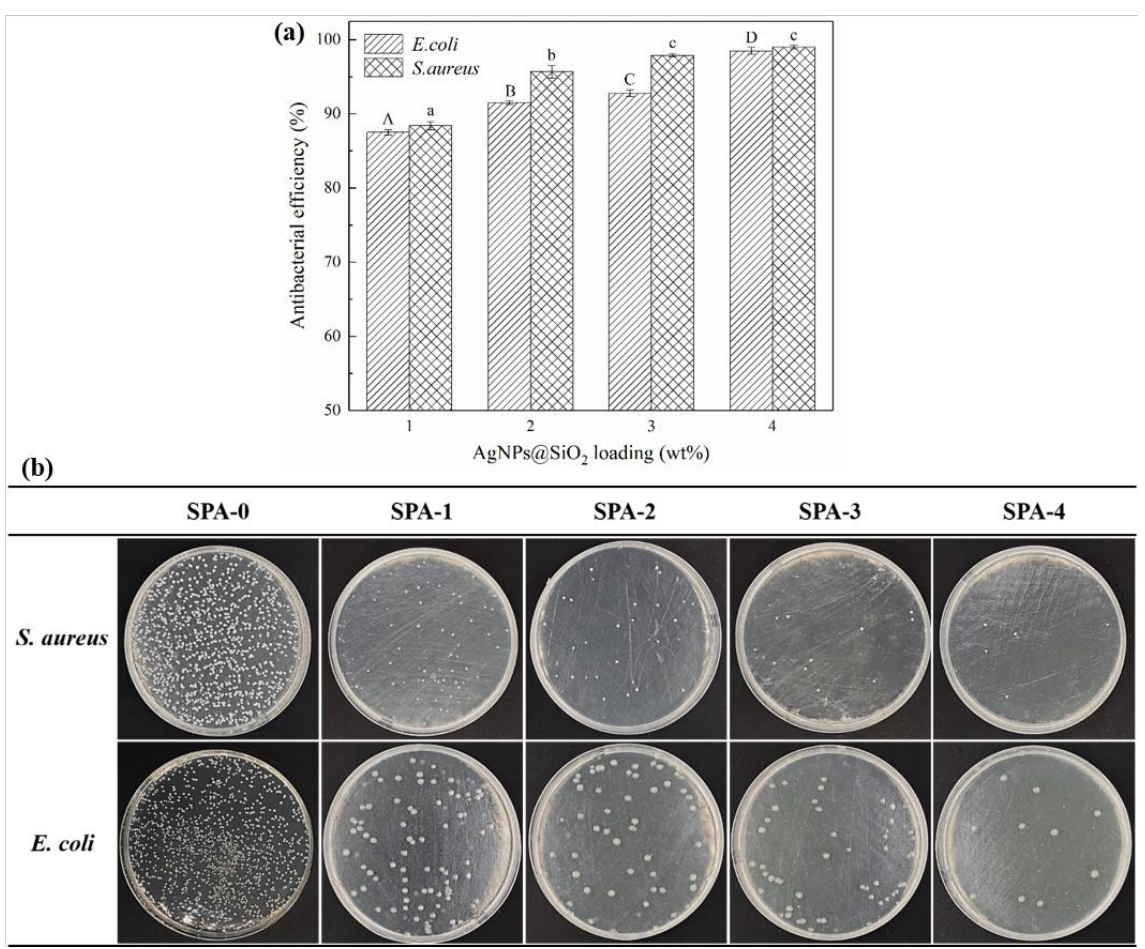
Figure 6. Antibacterial efficiency ( a ) and representative photos ( b ) of antibacterial testing of antibacterial films against S. aureus and E. coli after 3 h of contact. Results are reported as means ± standard deviation of triplicate determinations. A–D and a–c: Different designations within the same tested microorganism indicate significant differences among the samples ( p < 0.05).